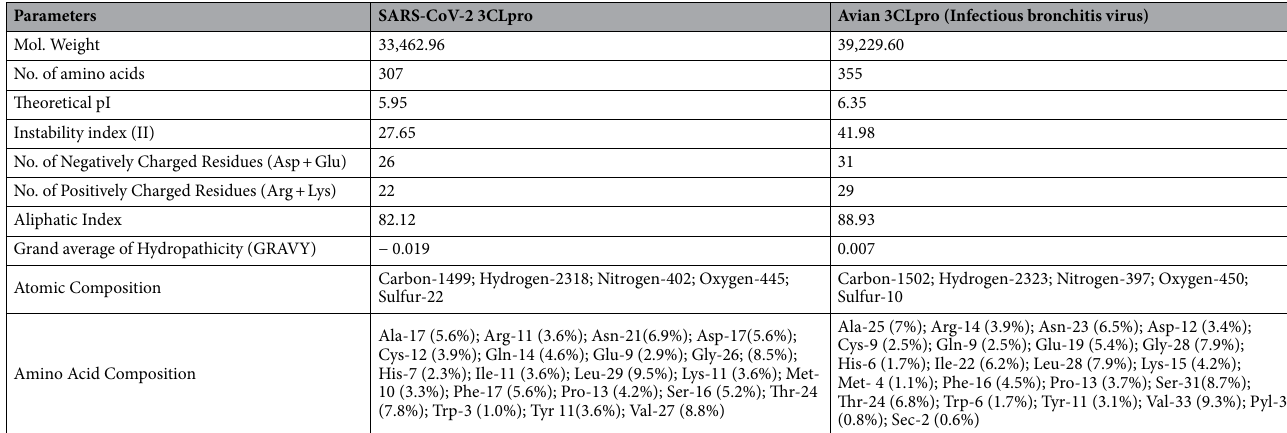
Table 1. Physicochemical parameters of SARS-CoV-2 3CLpro and avian 3CLpro of avian infectious bronchitis